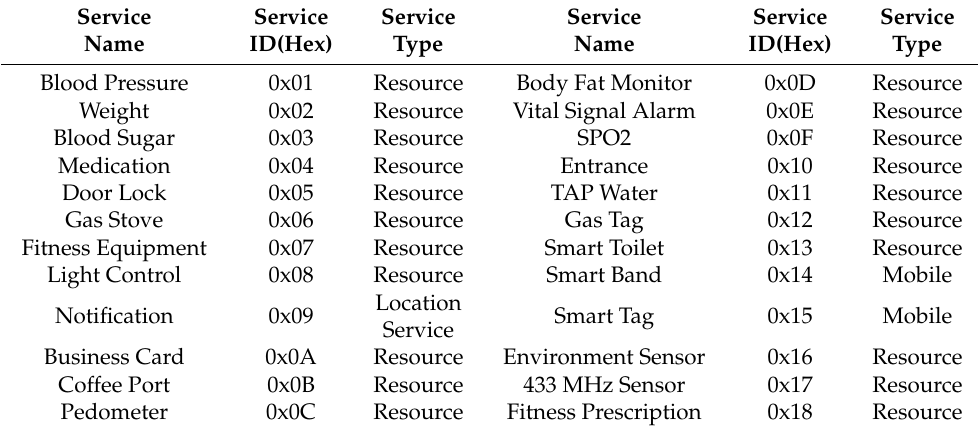
Table 2. Service ID for ADL Events.